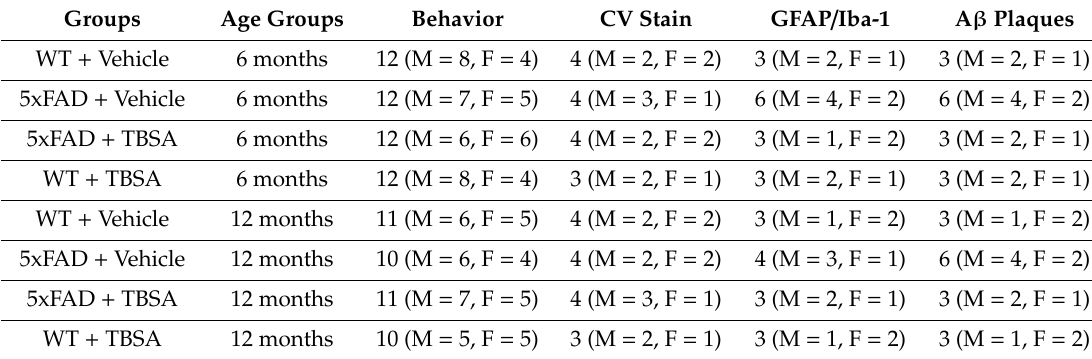
Table 1. Groups and number of animals for key measures.